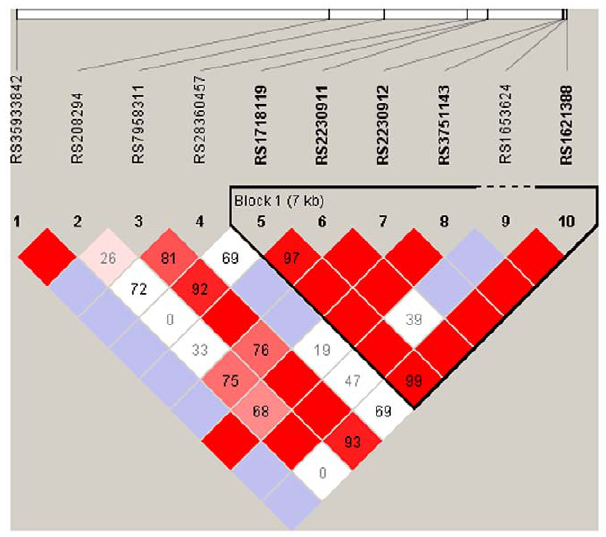
Figure 2. The strength of linkage disequilibrium (LD) between pairs of SNPs in ABD controls for P2RX7 . The heavy-line frame shows suggested haplotype blocks. The numbers in the squares represent the pair-wise D 9 value, empty squares stand for D 9 =1. Pink- red color indicates a pair-wise LOD $ 2 with redness proportional to D 9 . White-blue square indicates LOD , 2.